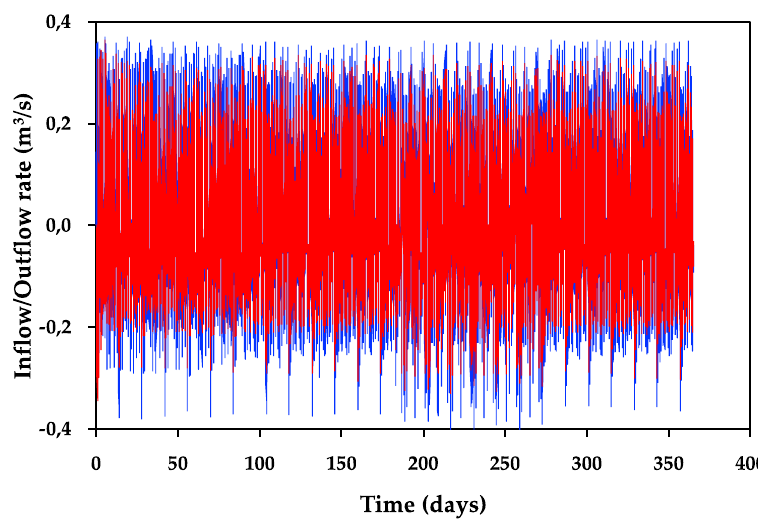
Figure 11. Water exchange rate (m 3 / s) evolution for the F-CI ( blue ) and E-CI ( red ) scenarios. Inflow into the underground reservoir is positive while outflow is negative.